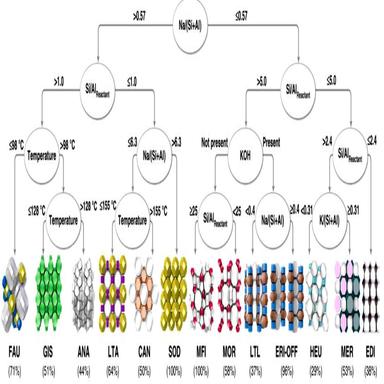
Decision tree constructed from the trained model with the highest accuracy of the XGBoost and this model was interpreted as a decision tree shown here with a depth of 4. Reproduced with permission from Springer Nature.